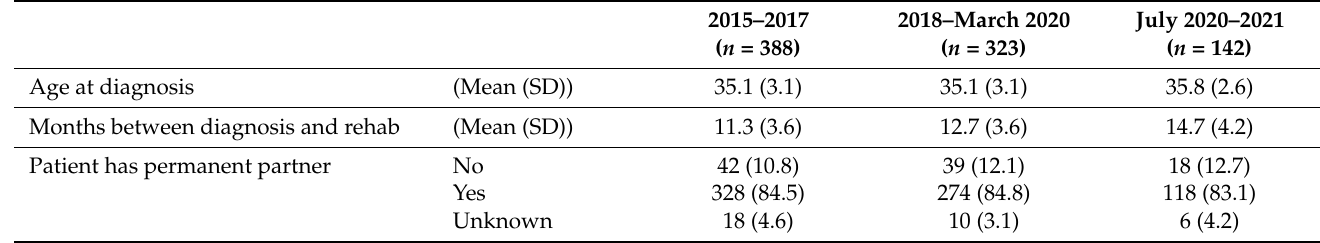
Table 1. Socio-demographic characteristics of young adult non-metastatic breast cancer patients with minor children participating in a 3-week inpatient mother–child rehab program according to time of rehab